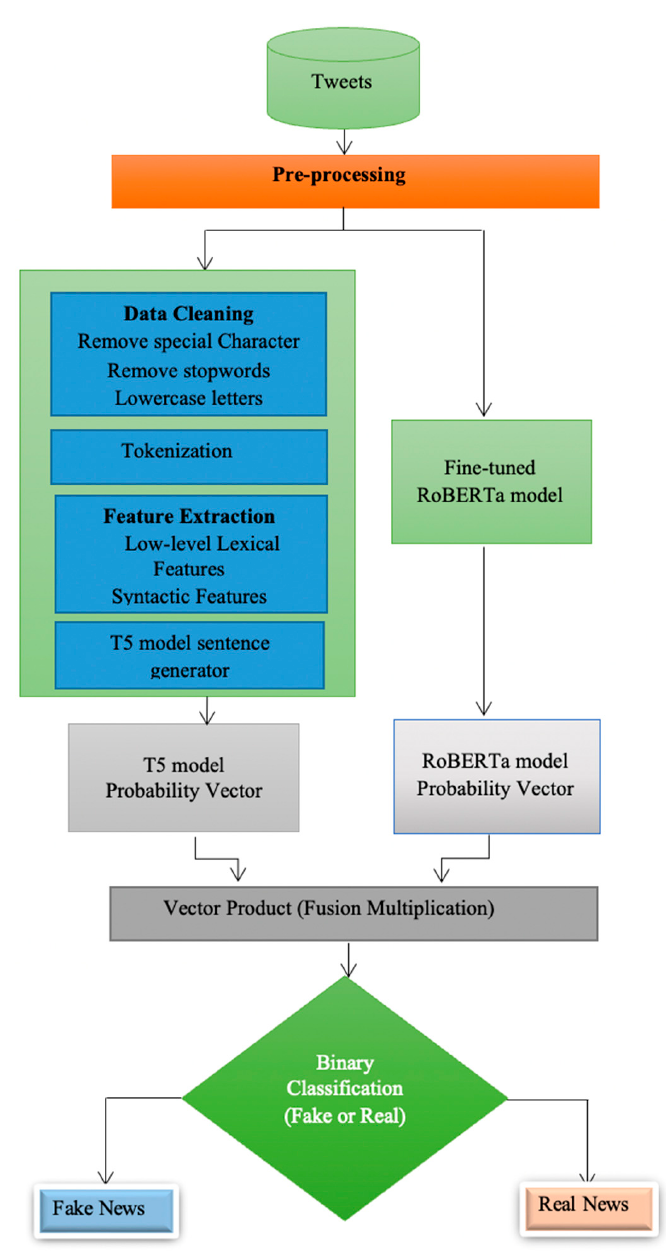
Figure 5. Proposed model for identifying fake news on social media.